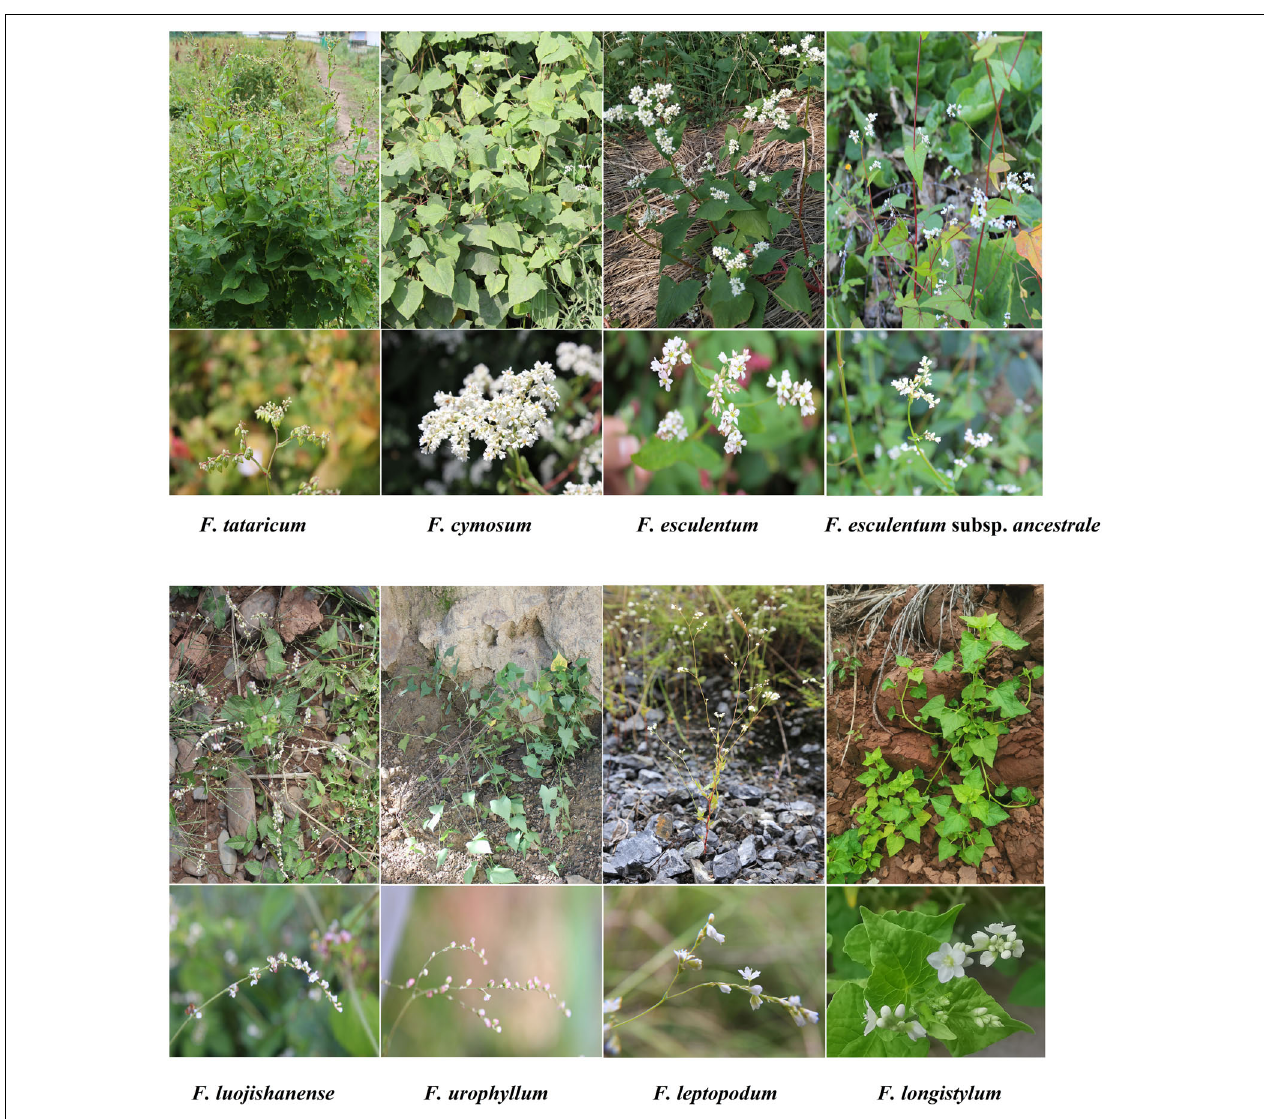
FIGURE 1 | The morphological characters of plants and flowers of eight Fagopyrum species. (A) F. tataricum ; (B) F. cymosum ; (C) F. esculentum ; (D) F. esculentum subsp. ancestrale ; (E) F. luojishanense ; (F) F. urophyllum ; (G) F. leptopodum ; (H) F. longistylu